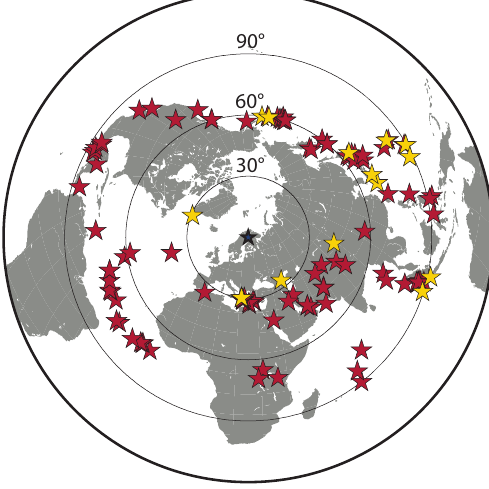
Figure 2. Location of the 111 teleseismic events used as sources for the tomography study. The centre of our array is shown with the blue star, while events recorded by the POLENET/LAPNET ar- ray are shown with red stars (96 events) and those recorded by the SVEKALAPKO project with yellow stars (15